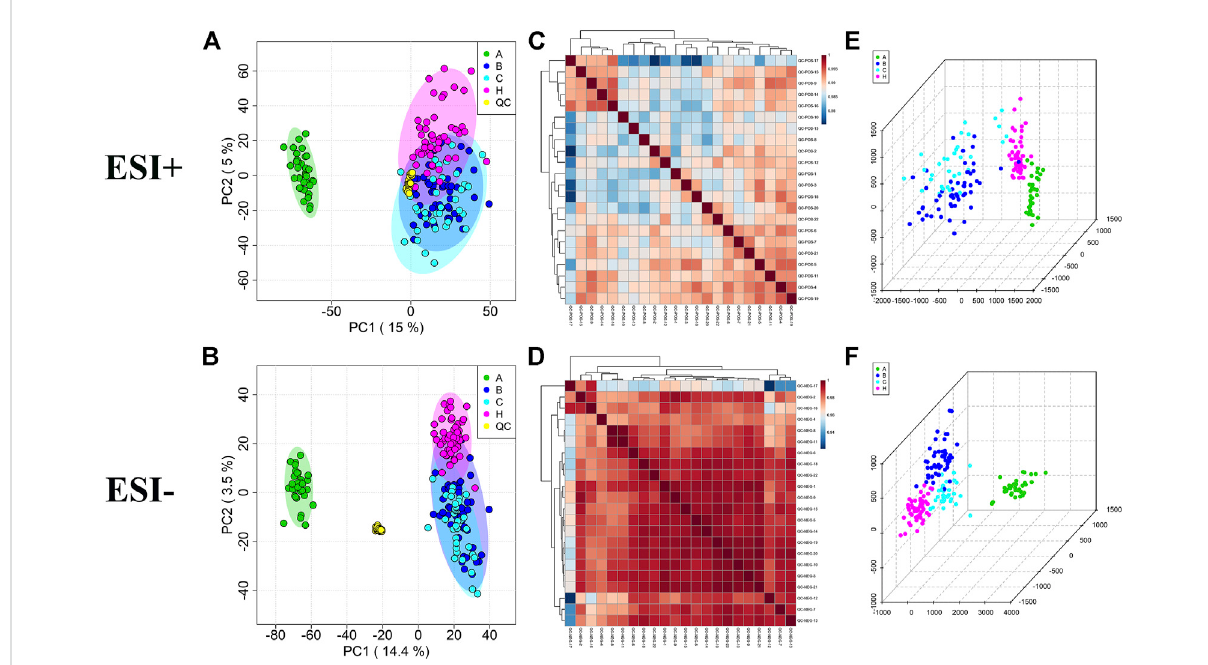
FIGURE 1 Multivariate statistical analysis in A, B, C and HC groups. (A,B) PCA score plots with QC samples; (C,D) Correlation analysis of QC samples in the ESI+ and ESI − scan modes. (E,F) OPLS-DA score plots of A, B, C and HC groups in the ESI+ and ESI − scan